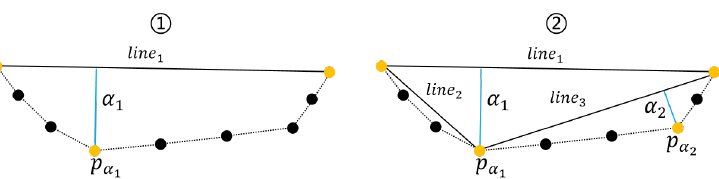
Figure 4. Illustration of the keypoint detection algorithm. Black dots are edge pixel points, yellow dots are keypoints.